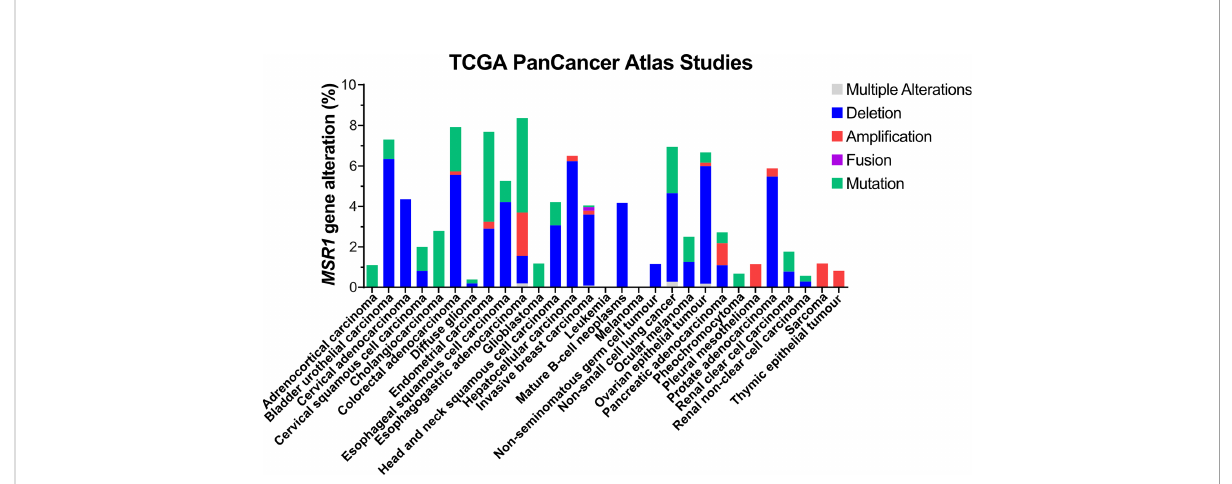
FIGURE 4 Genetic alterations of MSR1 in human tumour tissues. Data obtained from TCGA PanCancer Atlas Studies in 10967 tumour samples from various